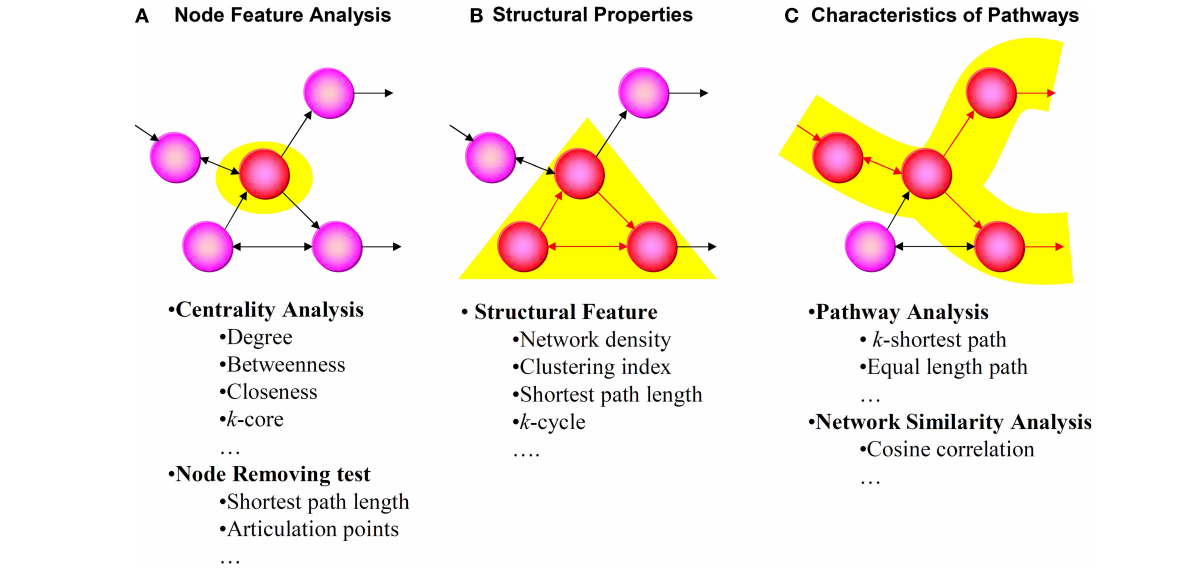
FIGURE 1 | Analysis methods of the BioNetpy module. We used the BioNetpy module to perform the following three types of analyses: (A) node feature analysis (centrality and changes in indicators upon removal of node), (B) structural properties, and (C) characteristics of pathways (analysis of network similarity and pathways analysis). BioNetpy and Supplementary Material can be downloaded from